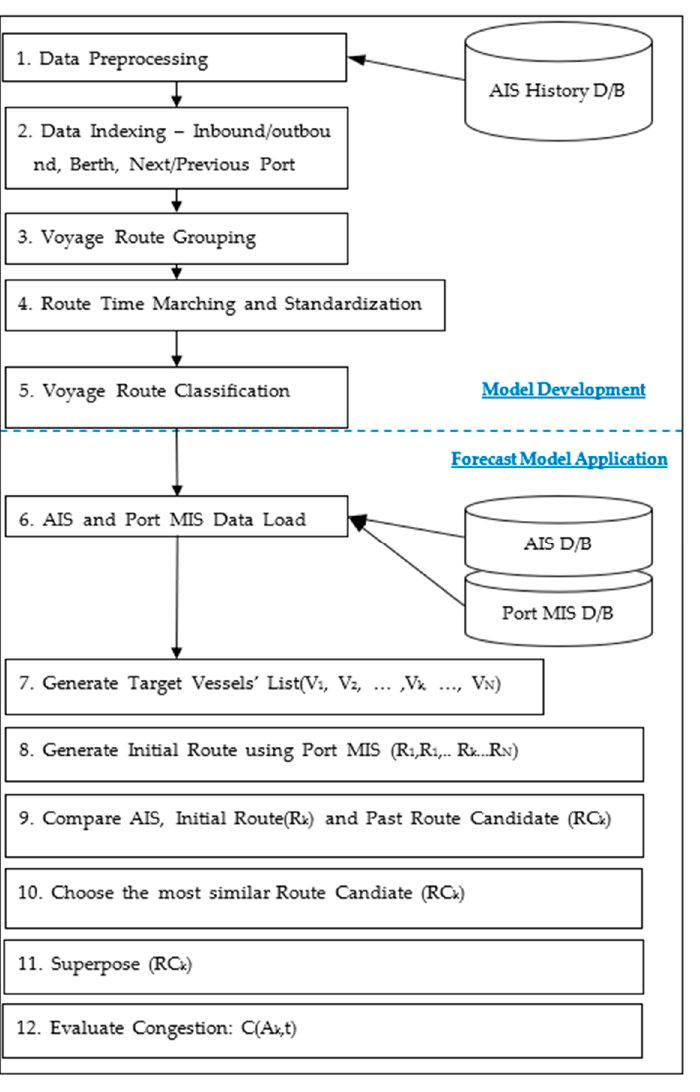
Figure 3. Schematic diagram—overall research